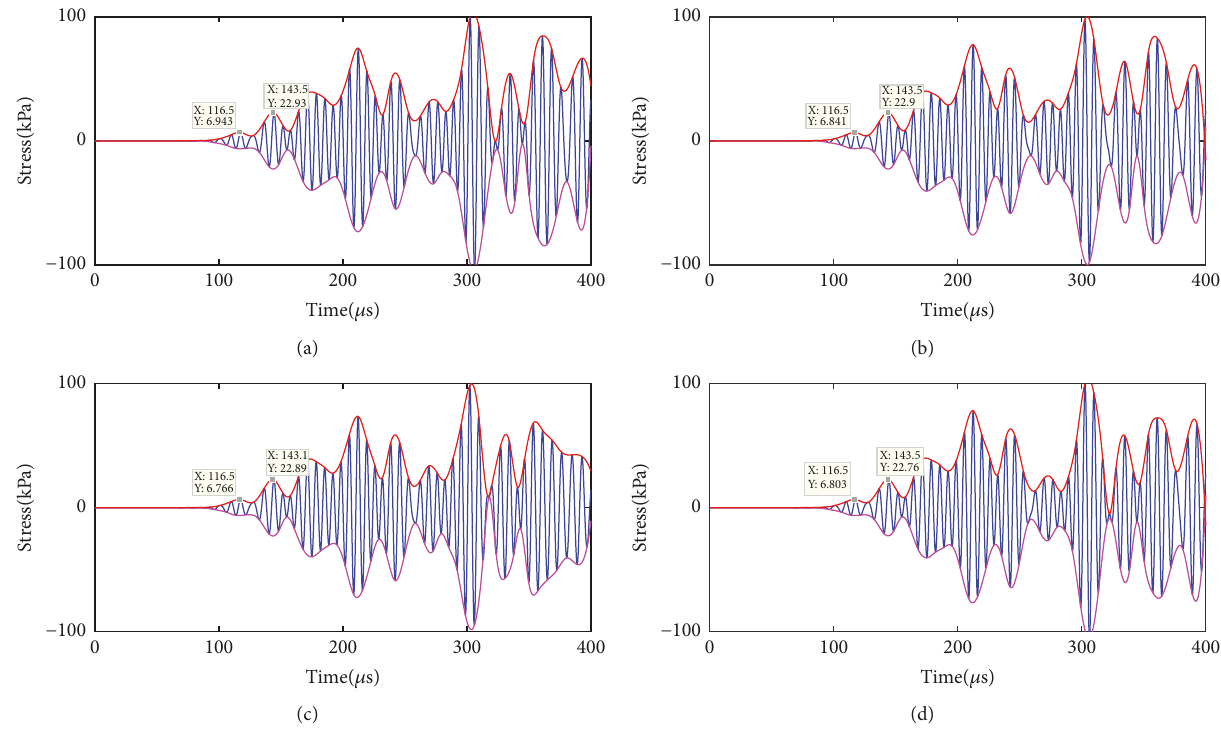
Figure 10: Collected signals of stress collection points (a) no. 1, (b) no. 2, (c) no. 3, and (d) no. 4 when the rotor is at rest.